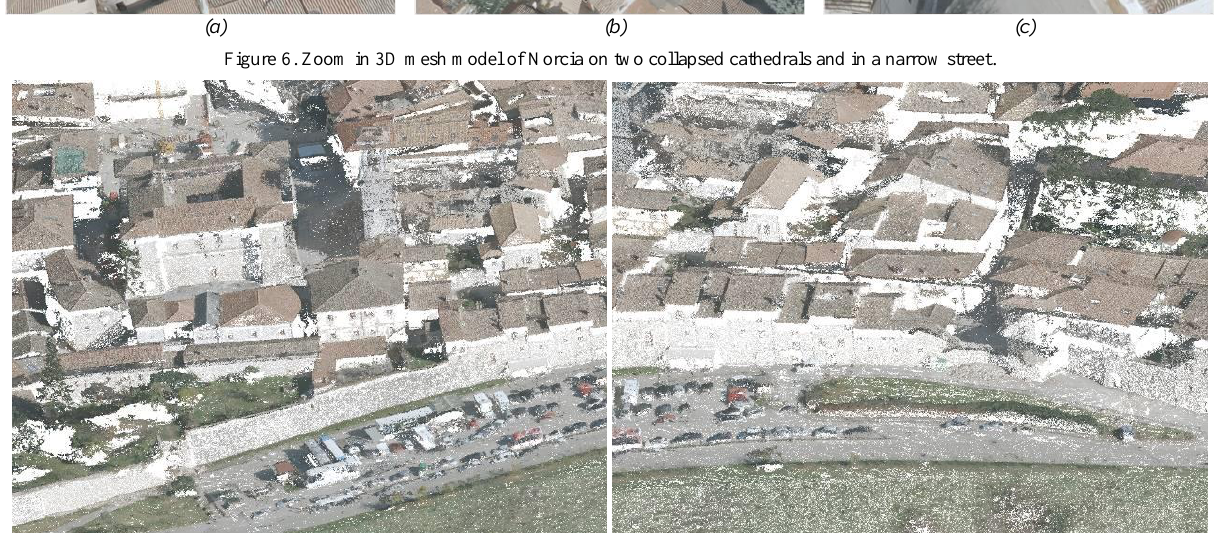
Figure 6. Zoom in 3D mesh model of Norcia on two collapsed cathedrals and in a narrow street.